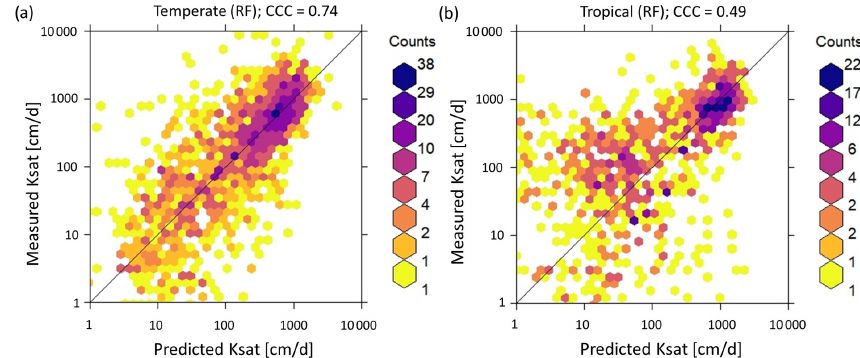
Figure 6. Correlation between observed and predicted K sat values obtained from the random forest (RF) model. The RF-based pedotransfer function (PTF) model was obtained by fitting 6637 training points measured in a temperate climate and tested on (a) data from temperate climate (1659 measurements) and (b) data from tropical areas (1111 measurements). PTFs showed good performance (CCC = 0.74) for the measurements taken in the temperate climate (including both laboratory and field measurements), but lower CCC values were obtained for tropical soil measurements (0.49 for RF). PTFs determined for temperate regions cannot be easily transferred to tropical regions because of the different soil forming